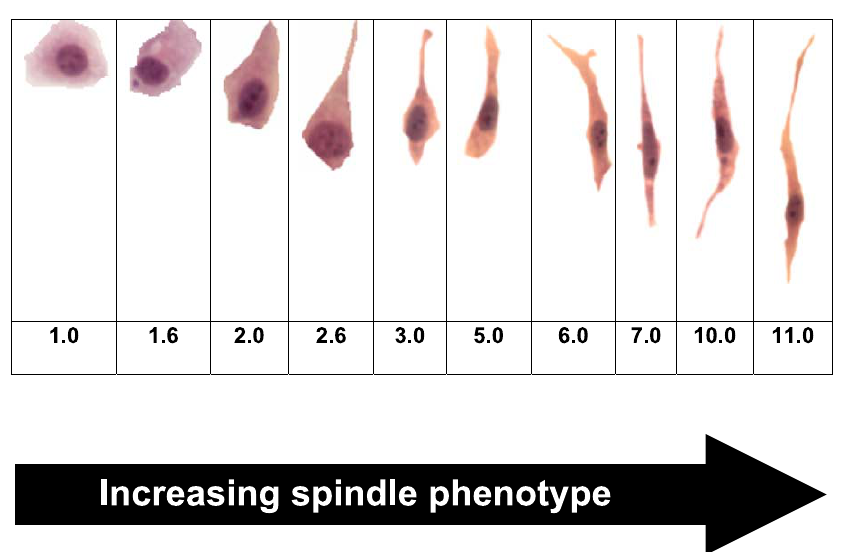
Fig. 5. Spindle Index was greatest in cells with the most pronounced spindle phenotype. The Spindle Index was derived from the ratio of maximum length to maximum width in individual AY-27 cells. As the Spindle Index increased the spindle morphology increased. This figure contains representative AY-27 cells which are predominantly of linear shape. (The colors are visible in the online version of the article.)